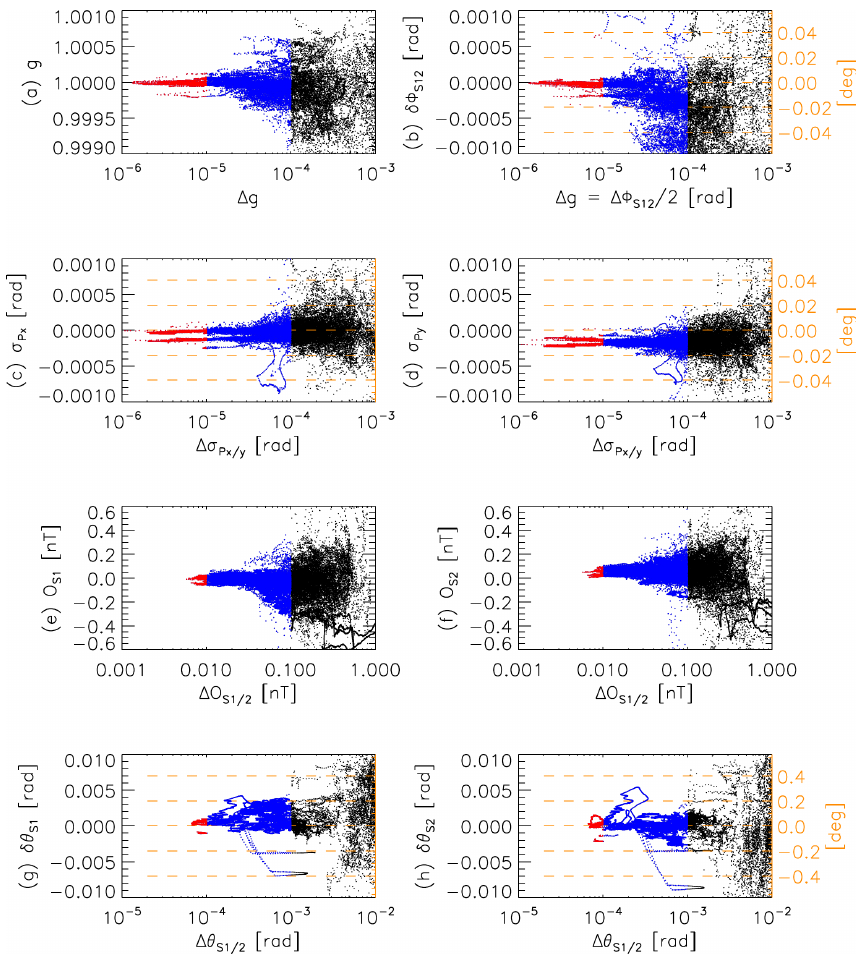
Figure 3. Calibration parameter estimates as a function of their respective uncertainties. Threshold levels for blue and red marked estimates are the same as in Fig. 2. Panels (b–d) , (g) , and (h) have secondary axes in orange, showing parameter values in degrees.